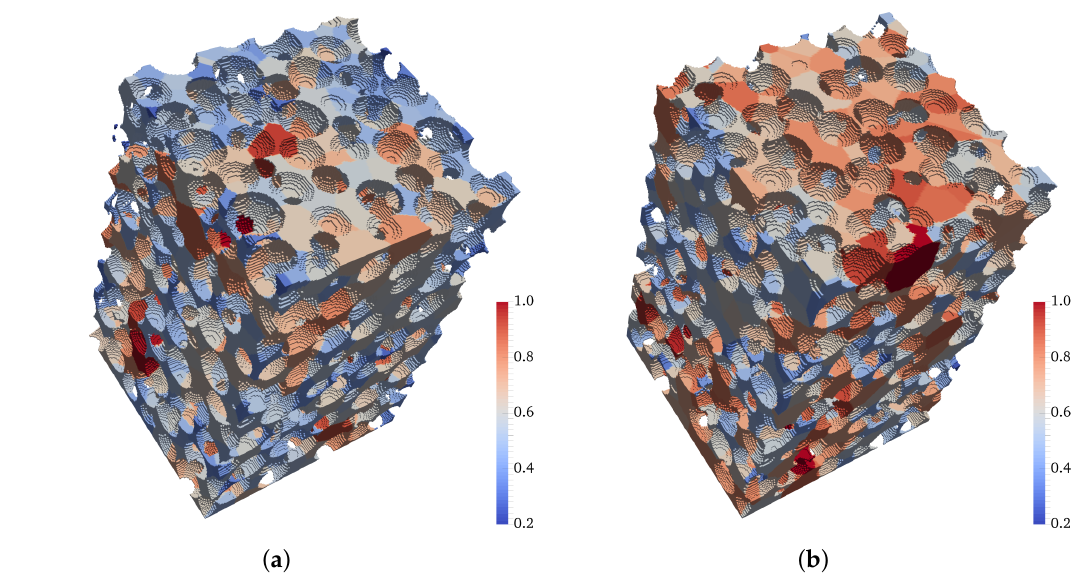
Figure 12. Pore segmentation visualization for four different models (color coded according to normalized pore size). ( a ) dense random packing; ( b ) very loose random packing.